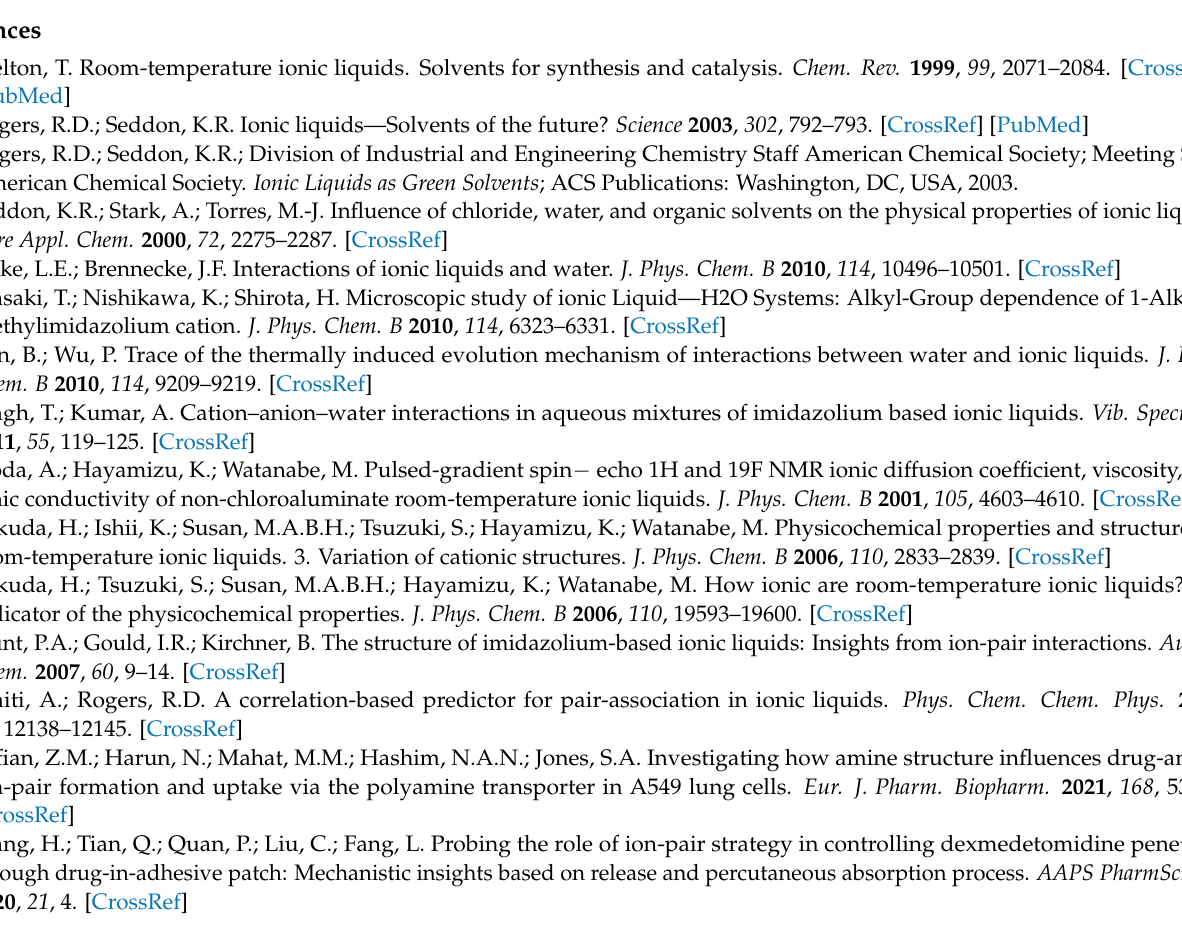
complex. Figure S2. 13C NMR of the proposed complex. Figure S3. IR spectrum of the proposed complex. Figure S4. Mass spectrum of the proposed complex, (A) Positive scan; (B) Negative